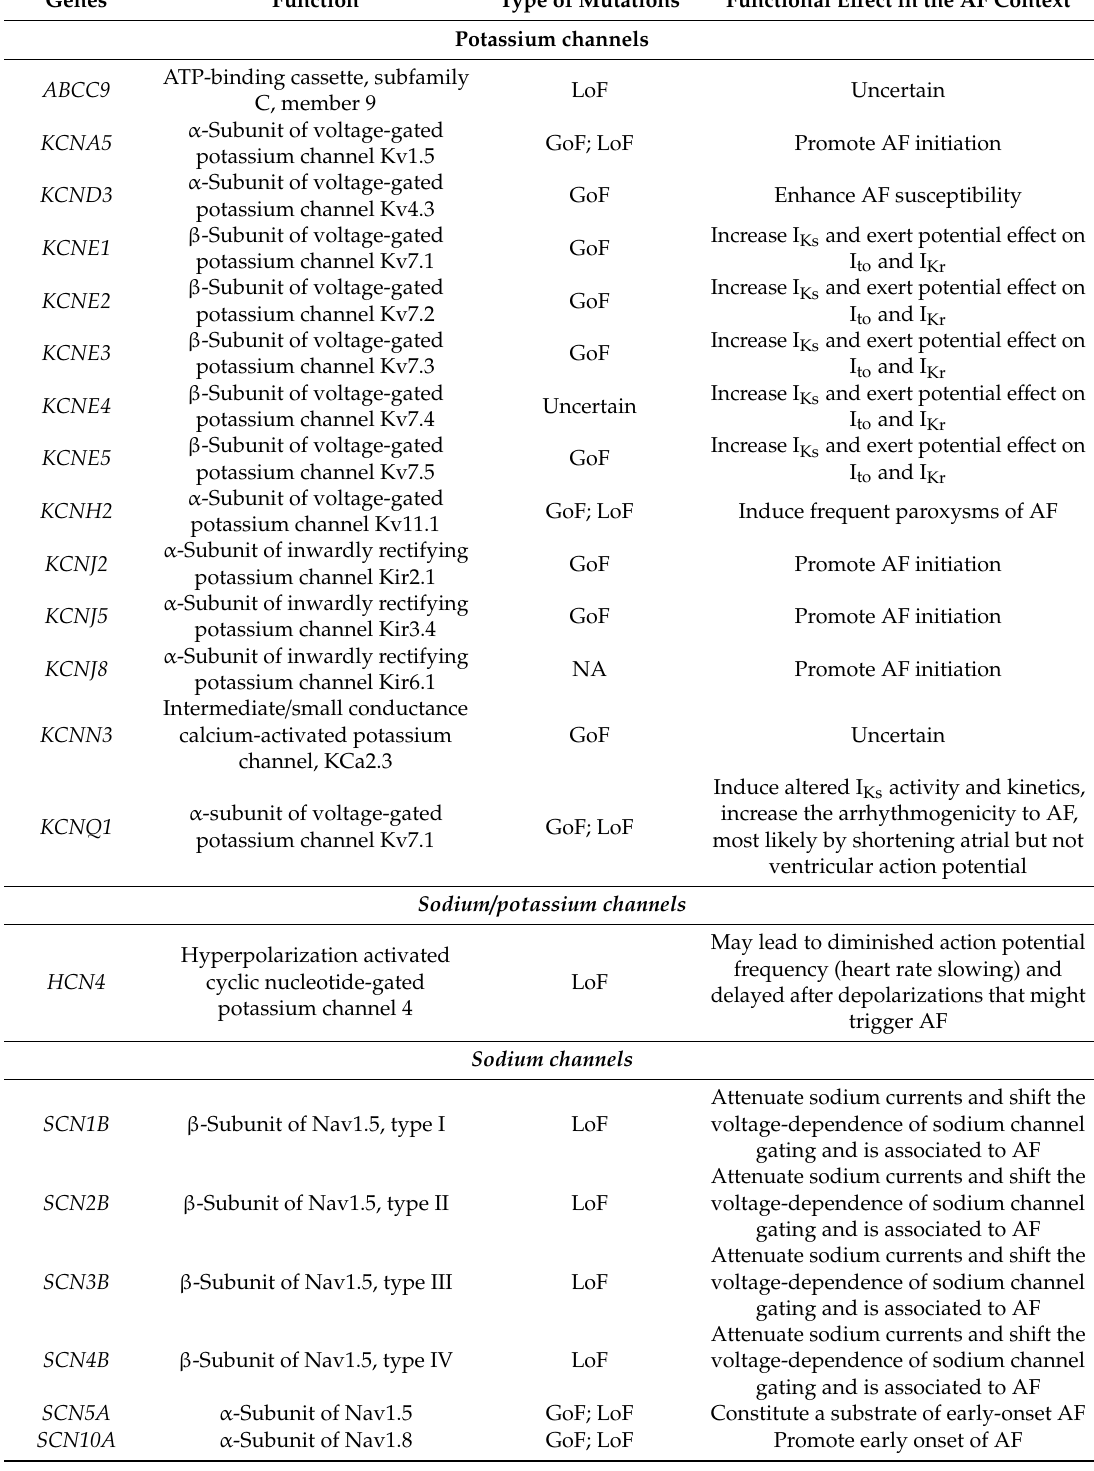
Table 1. Summary of the genes associated with atrial fibrillation